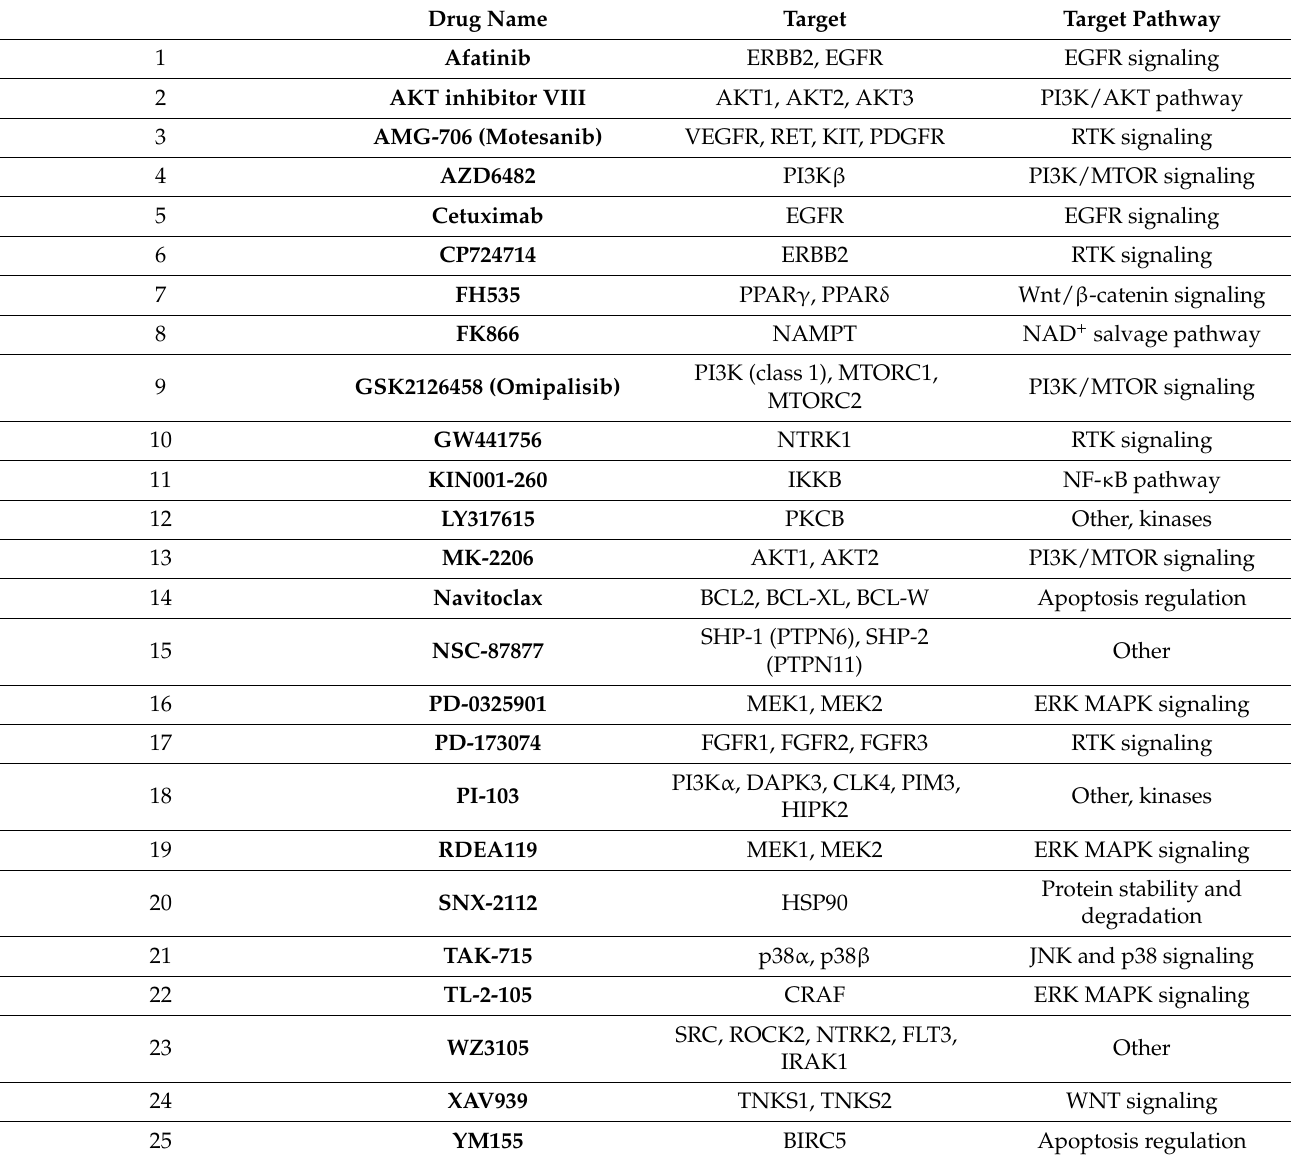
Table 1. Top drugs (‘secDrugs’) derived from our pharmacogenomics data-driven